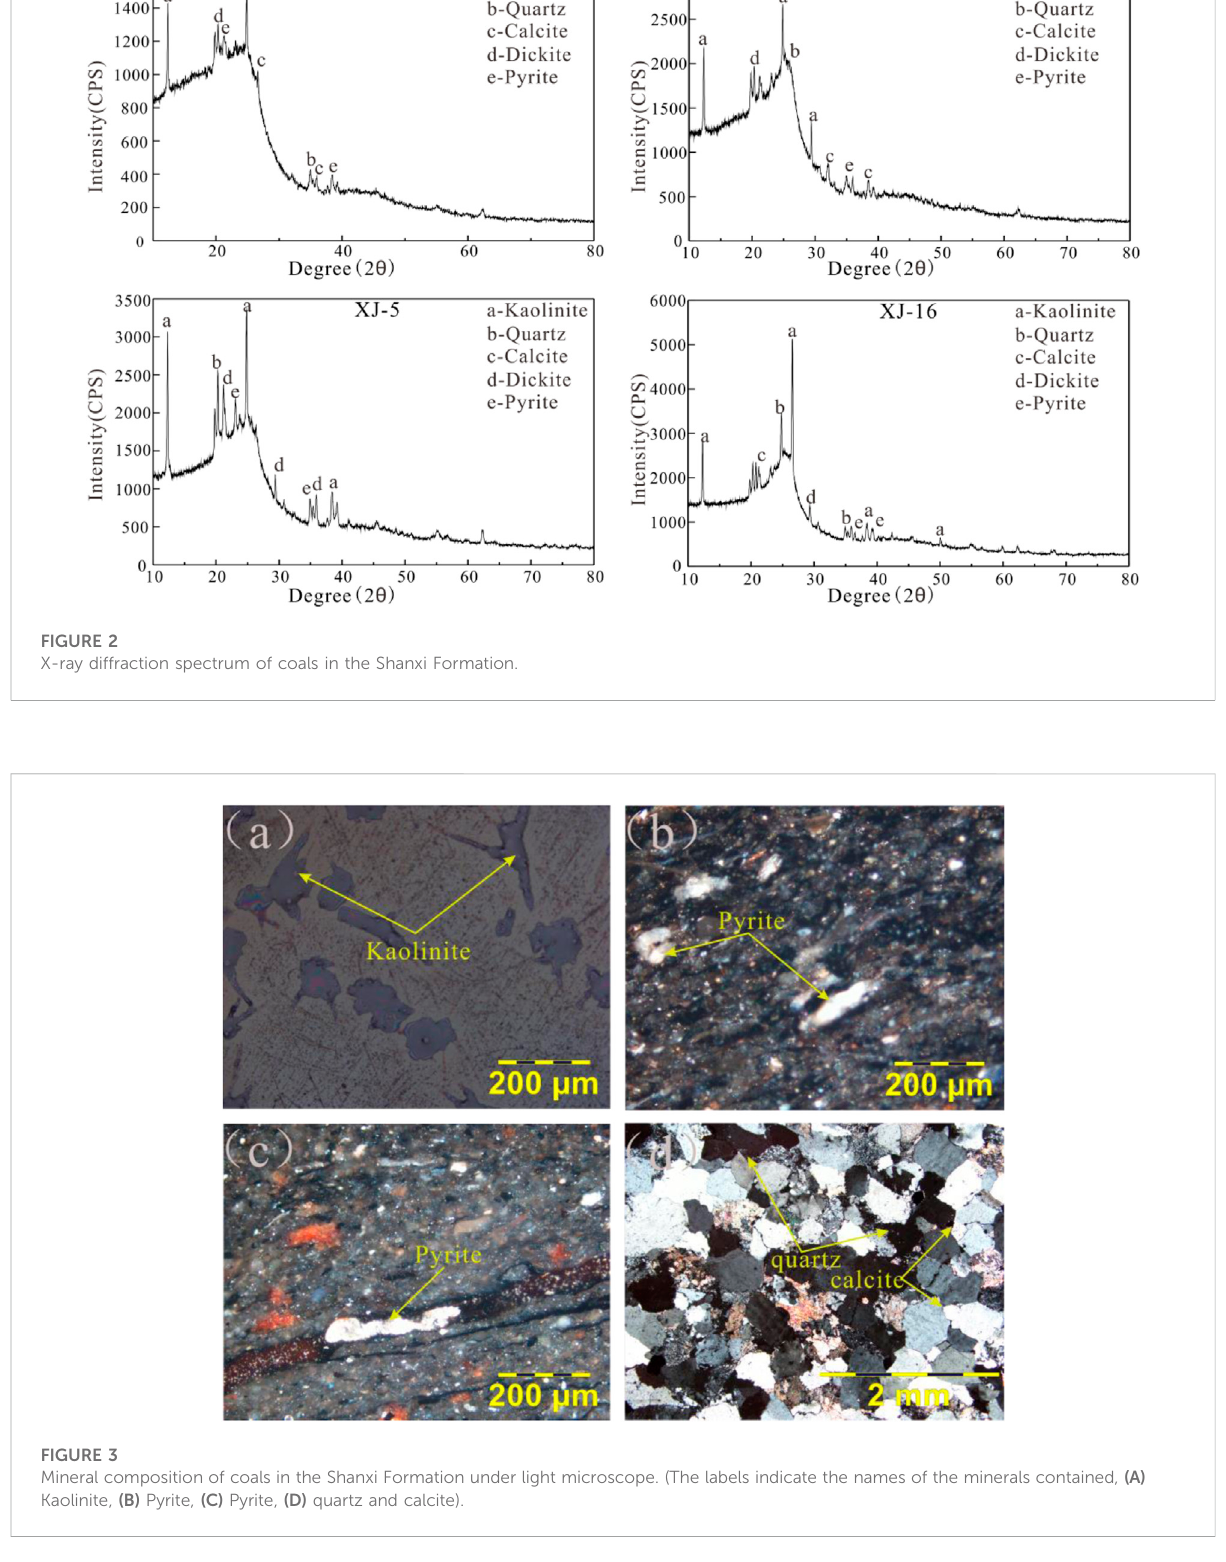
Frontiers in Earth